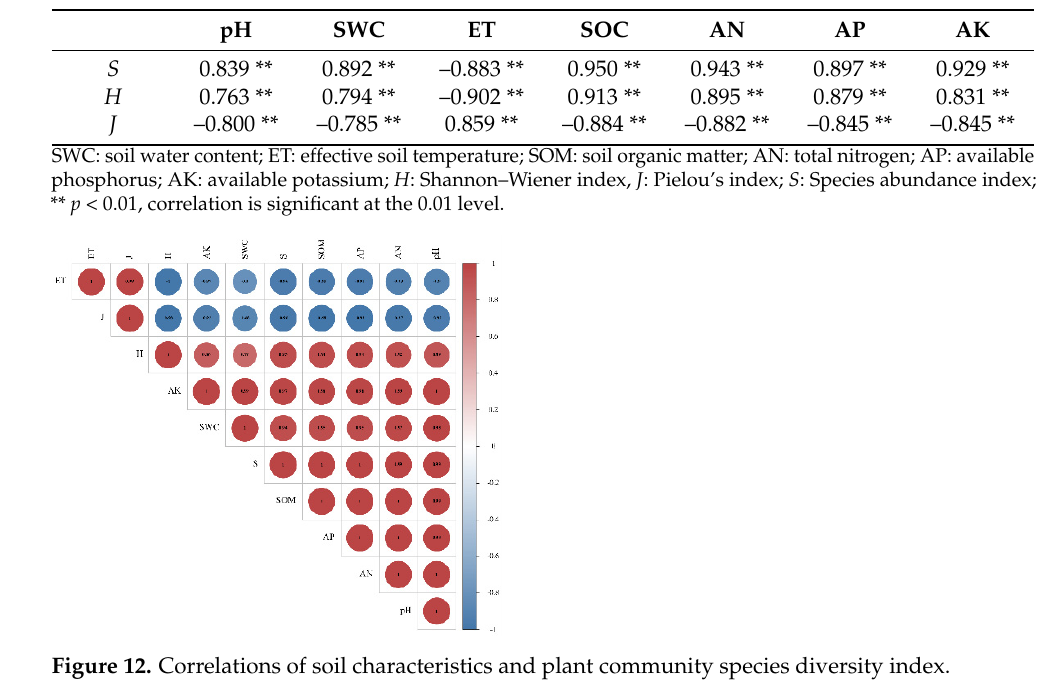
Table 3. Pearson’s correlations between the vegetation community structure and environmental factors.